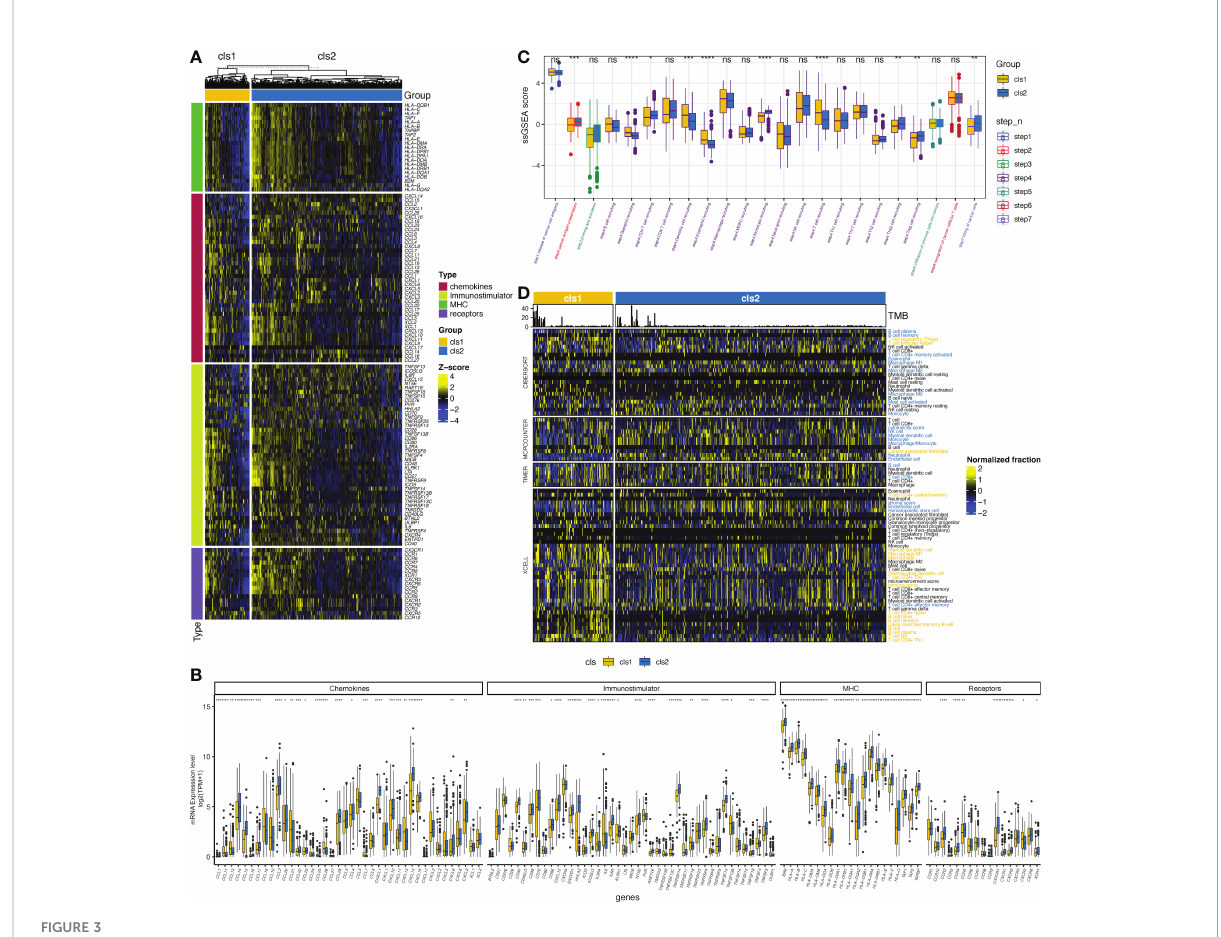
FIGURE 3 Claudin expression cluster and tumor microenvironment in ccRCC. (A) Difference in the expression of regulators of tumor immunology, including chemokines and their receptors, major histocompatibility complex (MHC), and immunostimulators between the two clusters in The Cancer Genome Atlas (TCGA)- kidney clear cell carcinoma (TCGA-KIRC) cohort. (B) Bar plot shows the difference of the expression of regulators of tumor immunology between two clusters. (C) Differences in the activity of seven steps of the cancer-immunity cycle between clusters. (D) Analysis of the difference in the tumor-in fi ltrated immune cells (TIICs) between the two clusters using multiple computational algorithms, including CIBERSOFT, MPCOUNTER, TIMER, and XCELL. TIICs with yellow color were signi fi cantly more enriched in cluster 1, whereas those with blue color were more enriched in cluster 2 (p< 0.05). *p< 0.05, **p< 0.01, ***p< 0.001, ****p< 0.0001, ns, not signi fi cant; TPM, transcript per million; ssGSEA, single-sample gene set enrichment